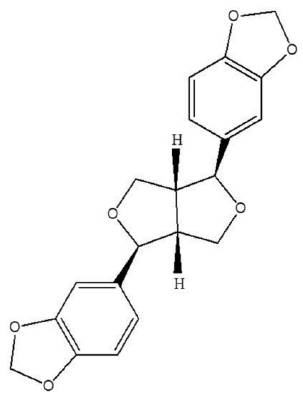
Figure 1. Chemical structure of sesamin.